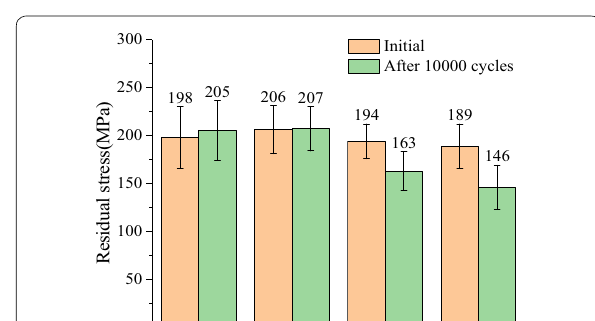
Table 6. After 10000 cycles, the residual stress on the surface of the samples was measured.